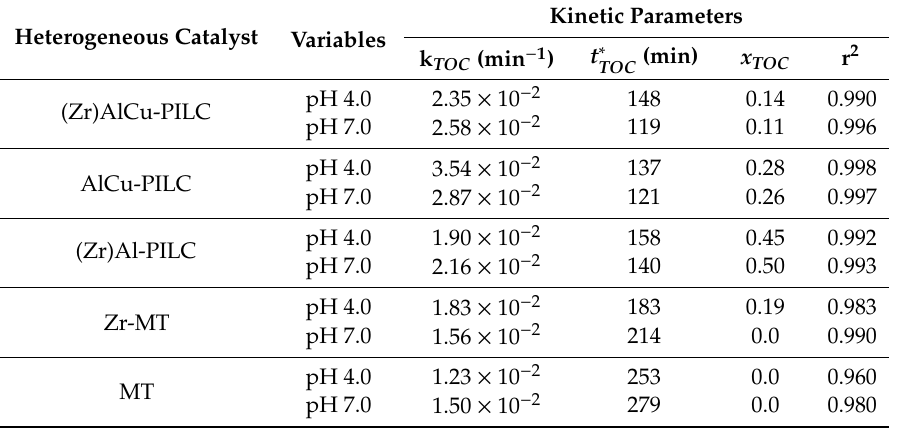
Table 4. Kinetic parameters obtained by fitting Fermi’s model to the experimental data ( TOC / TOC 0 as function of time) using di ff erent catalysts.